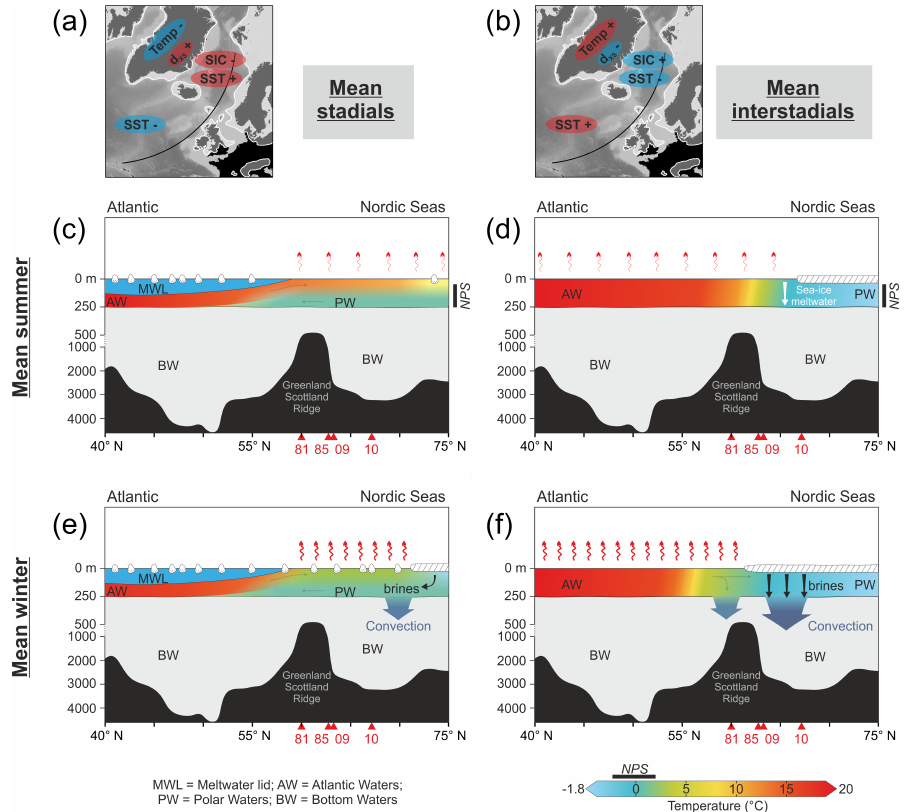
Figure 3. Conceptual hydrographical scheme. The diagrams depict the mean conditions in the sub-boreal Atlantic during stadials (left, a , c , e )/interstadials (right, b , d , f ), and summer (middle panels, c , d )/winter (lower panels, e , f ). Section location is indicated on the top maps. Bathymetry is from GEBCO (www.gebco.net), and has been simplified for sections. Ice-sheet extent on maps corresponds to the Last Glacial Maximum extension (Ehlers and Gibbard, 2007). Colours indicate temperature range, as indicated by the bottom scale. Potential depth range (Simstich et al., 2003) and optimal temperature range (Tolderlund and Bé, 1971) of NPS habitat, whose main production period occurs in summer in the Nordic Seas (Simstich et al., 2003), are also